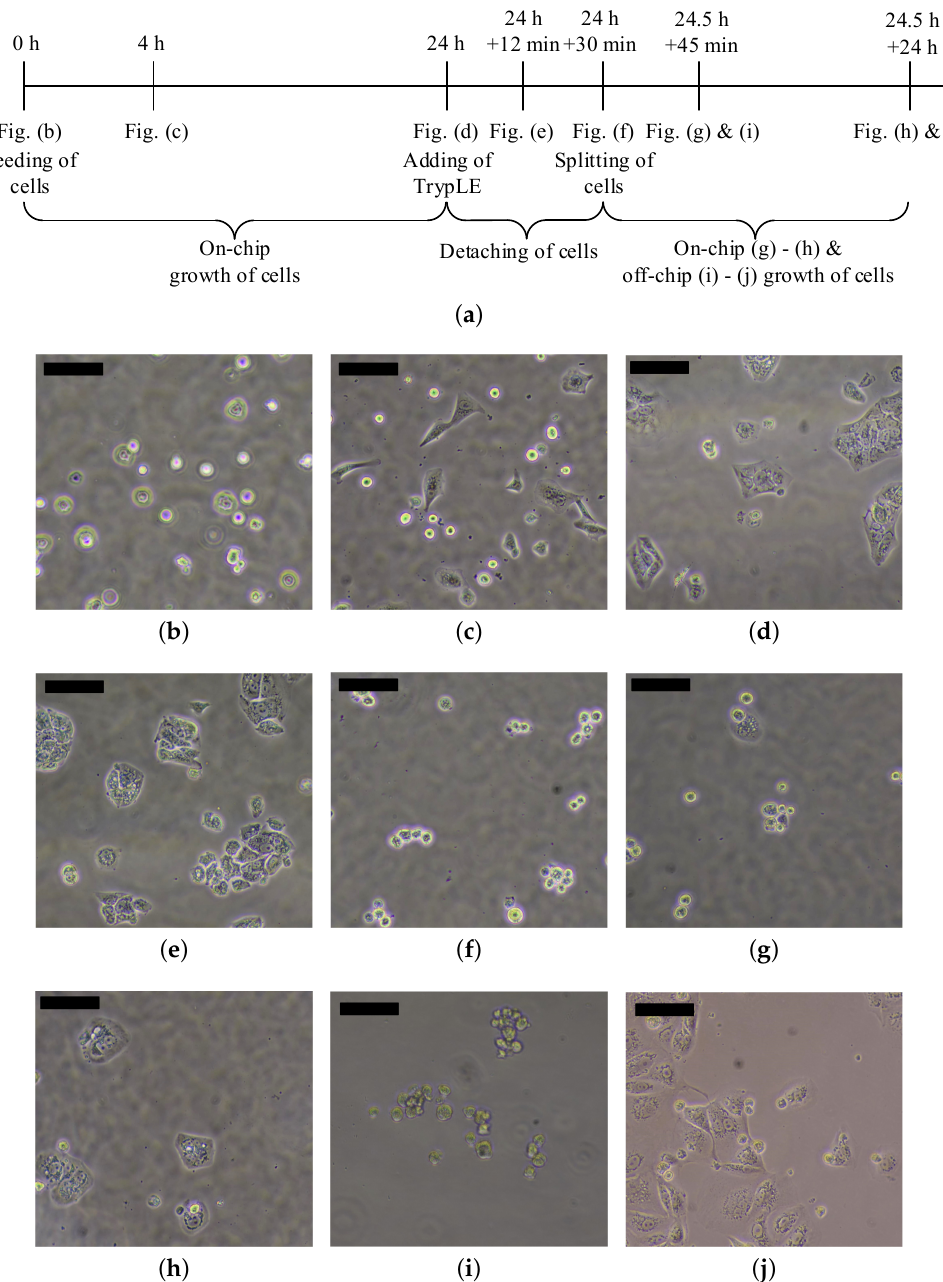
Figure 8. Culture of MDCK-cells (scale bar is 100µm): ( a ) overview about the experimental procedure (not to scale); ( b ) t = 0h: seeding of the cells inside the chip; ( c ) t = 4h: cells adhere on the bottom plate; ( d ) t = 24h: cell growth inside the chamber; ( e ) t = 24h (culture) + 12min incubation with TrypLE: first cells detach from the plate; ( f ) t = 24h + 30min incubation with TrypLE: Detaching of almost all cells; ( g ) t = 24.5h + 45min: A few cells remain inside the chip after the splitting; ( h ) t = 24.5h + 24h: on-chip growth of the cells; ( i ) t = 24.5h + 45min: the majority of the cells is removed from the chip after splitting and added in a 24-well plate; ( j ) t = 24.5h + 24h: off-chip growth of the